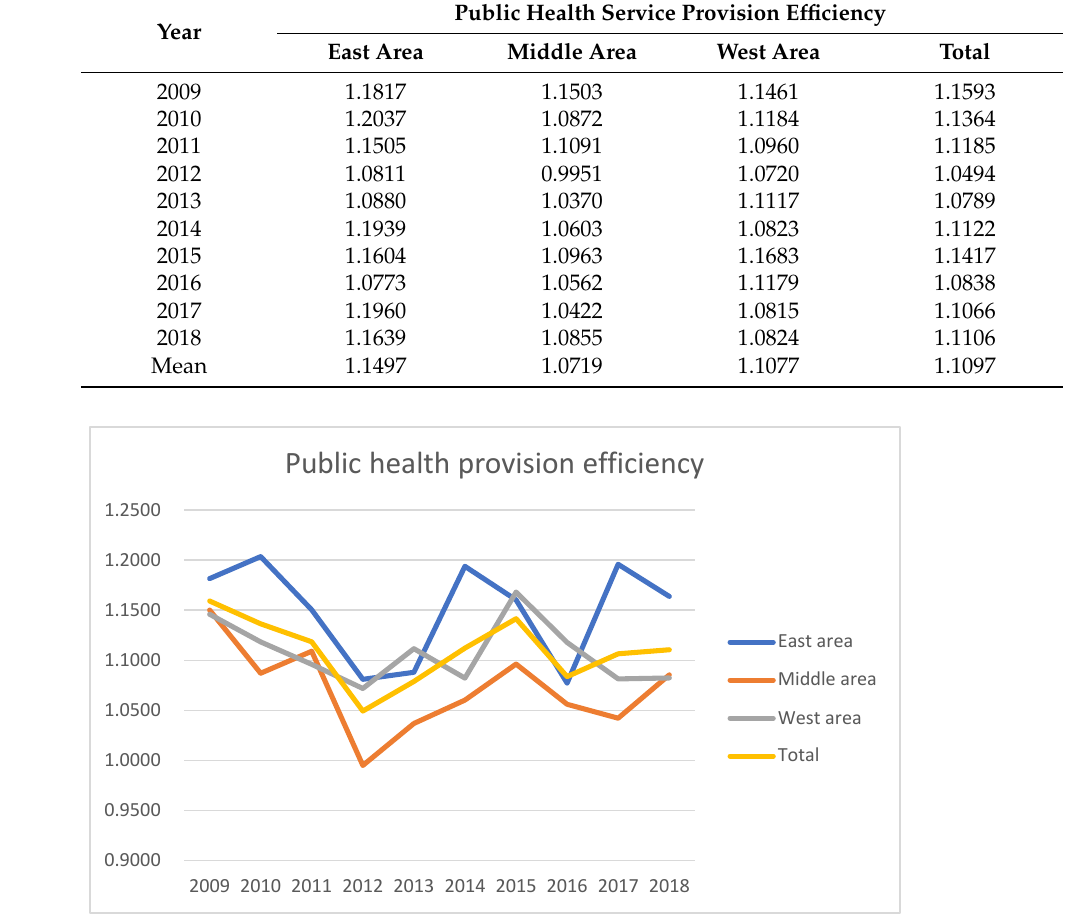
Figure 4. Geographic map of the mean value of public health service provision efficiency in 31 prov ‐ inces in China from 2009 to 2018.